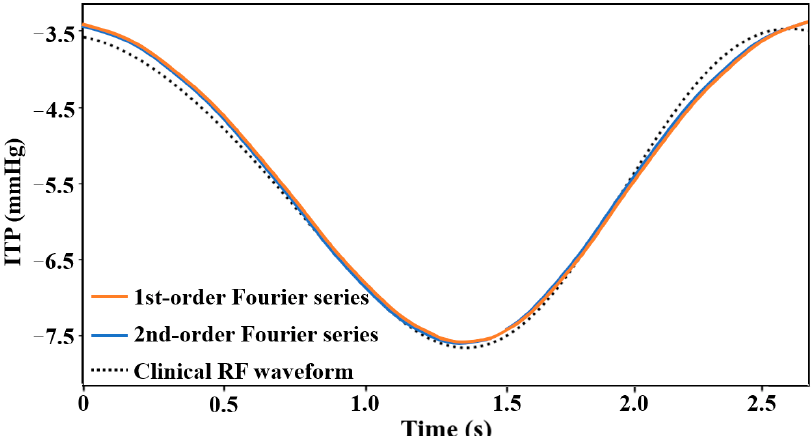
Figure 2. BP and RF waveforms extracted from a 12-year-old VSD patient in 1 min.